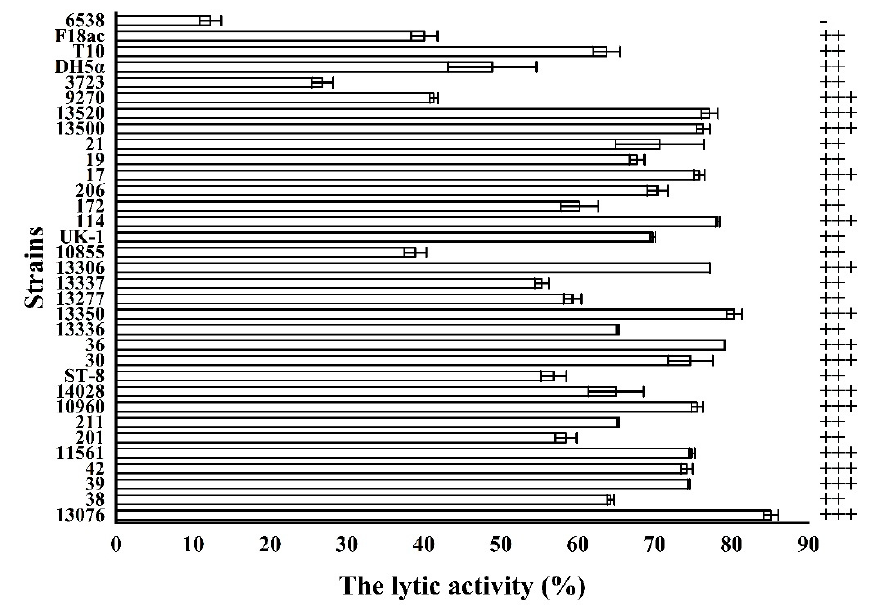
Figure 7. The lytic spectrum of the endolysin LysSE24. Calculate the lytic activity by using the formula 100% × (OD 600 nm of control − OD 600 nm of the reaction mixture with endolysins) / the initial OD 600nm of the control. Lytic activity between 20% to 30%, “ + ”; lytic activity between 31% to 70%, “ ++ ”; lytic activity between 71% to 100%, “ +++ ”; lytic activity lower than 20%, “–”.